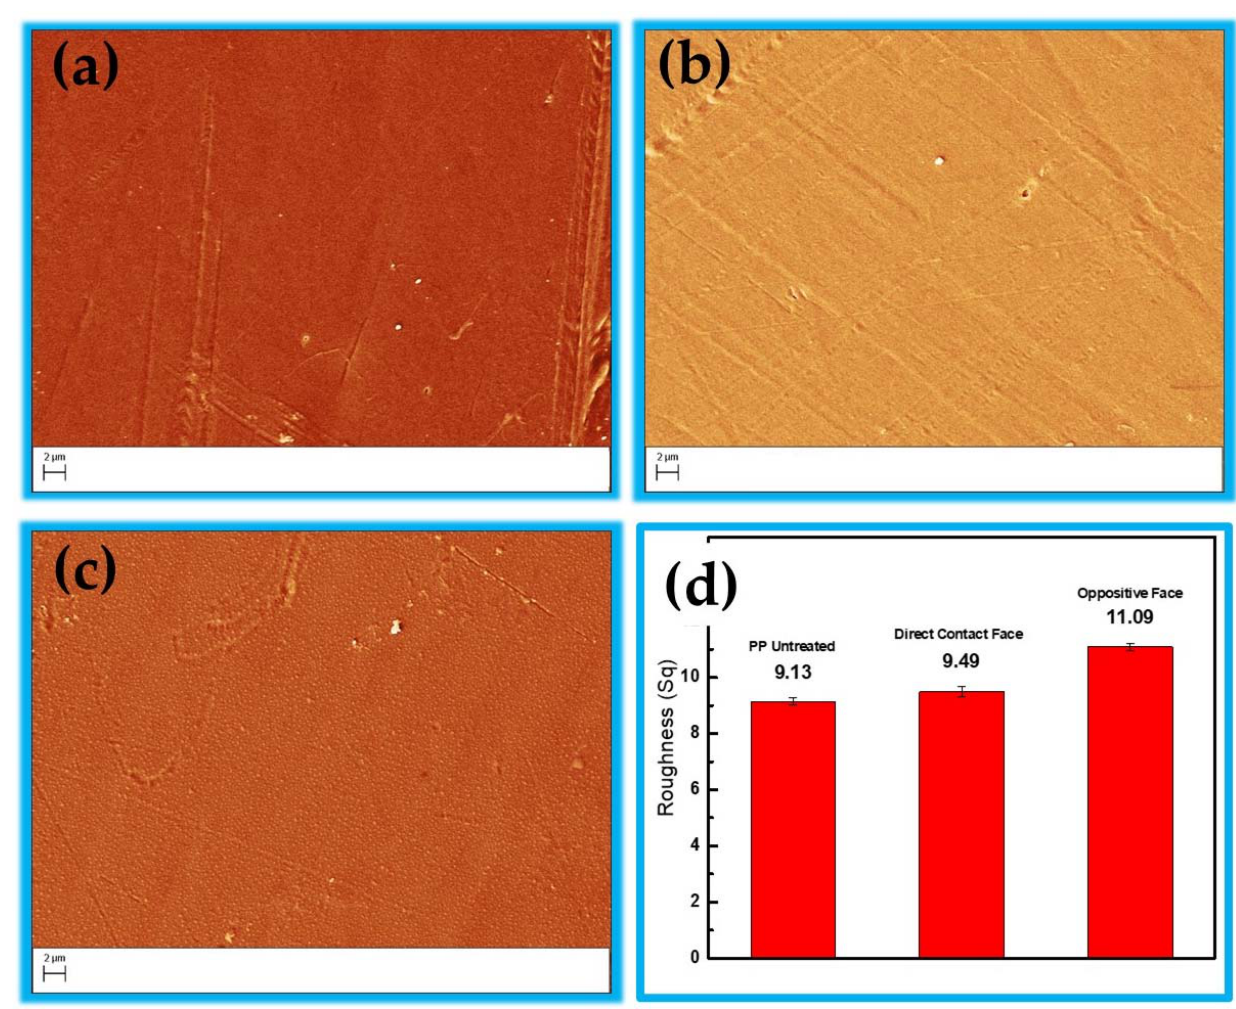
Figure 2. Scanning electron microscopy (SEM) images of polypoprylene samples: ( a ) untreated; ( b ) treated by plasma with direct face contact (DFC); ( c ) treated by plasma through the opposite face (OF); and ( d ) roughness values for all samples. All samples were treated for 3 min.